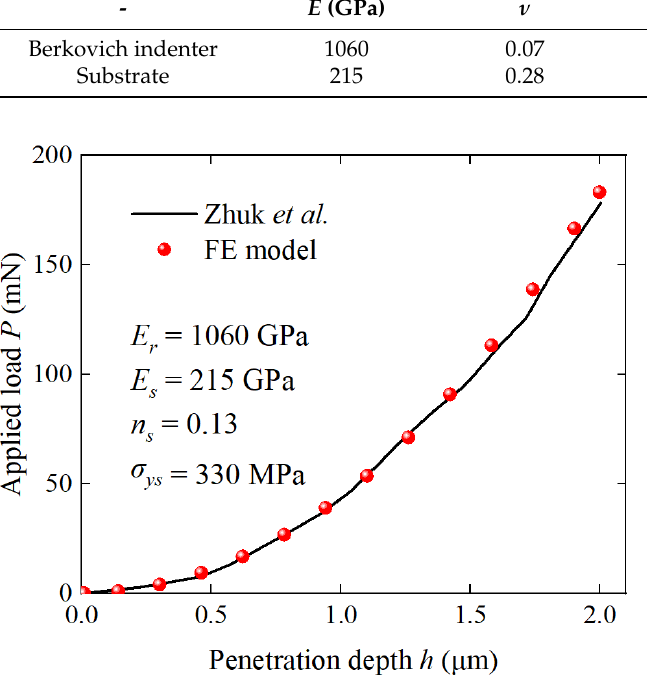
Figure 3. Response comparison of the established FE model and published result [34].